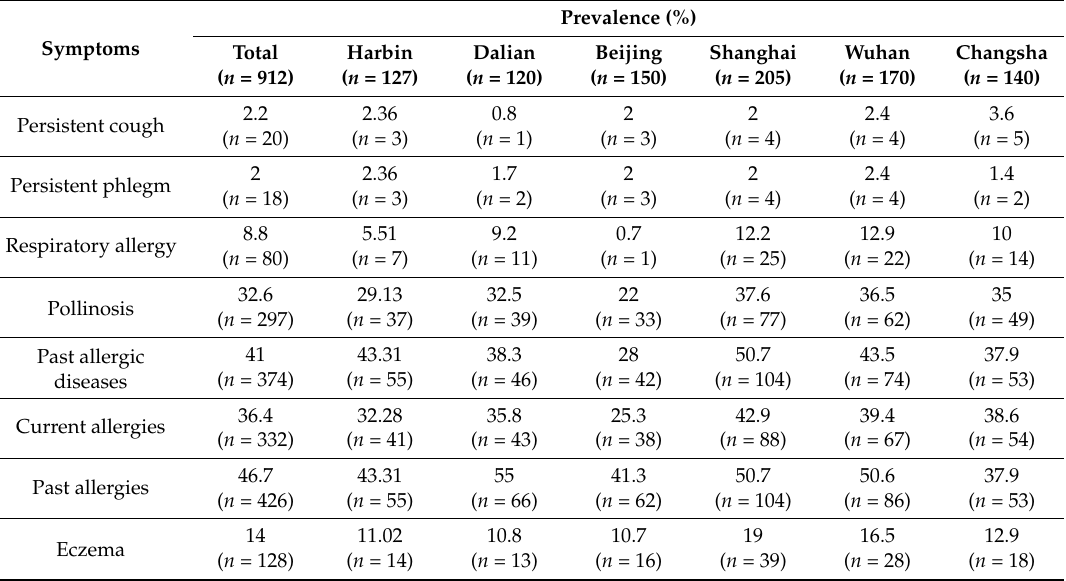
Table 1. The prevalence of childhood allergies and symptoms among six Chinese cities.